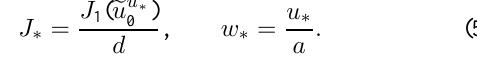
Figure 3 provides a unified limiting performance char-